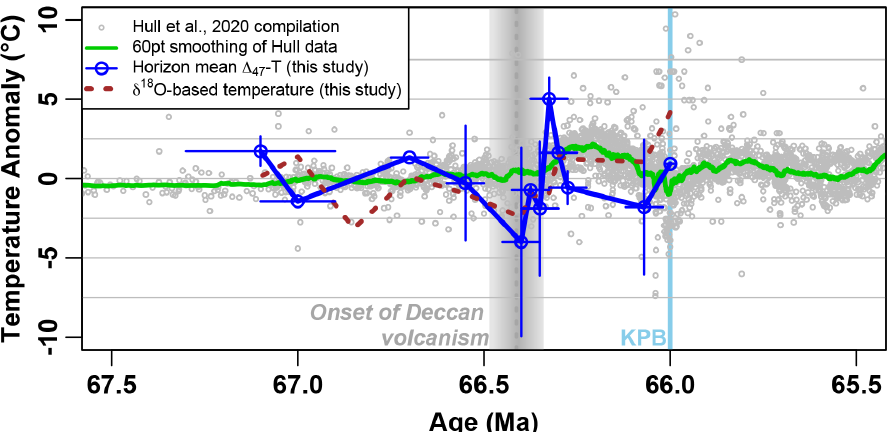
Figure 7. Temperature evolution through the Late Maastrichtian Warming Event. Comparison of new temperature data to the compilation of late Maastrichtian temperatures by Hull et al. (2020). Grey and light blue vertical bars indicate onset of Deccan volcanism and the KPB, as in Fig. 5. Vertical error bars on horizon averages represent 1SD of all temperatures from a given horizon. Horizons with no error had only one sample. Horizontal error bars represent uncertainty in the age model of Vellekoop et al. (2022). The brown dashed line indicates a temperature profile calculated from δ 18 O carb assuming a fixed δ 18 O sw value of − 1‰ VSMOW and, similarly to the Hull et al. (2020) composite record, shows peak temperatures delayed relative to the (cid:49) 47 -based temperature peak.